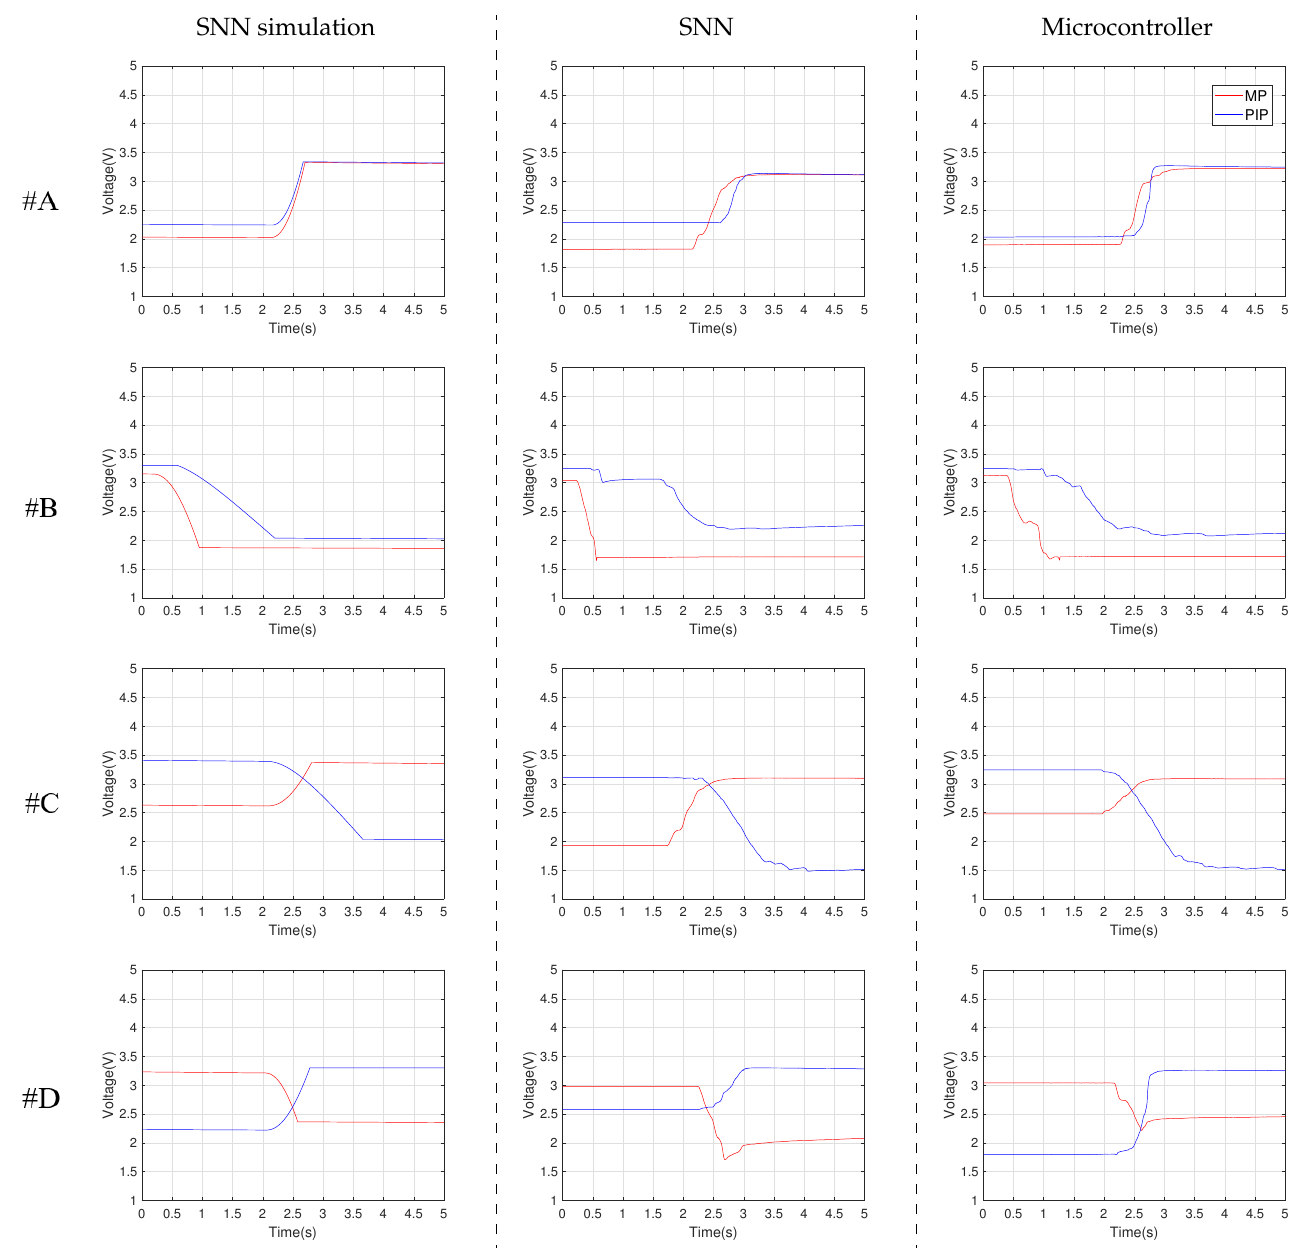
Figure 7. The output of the flex sensors for the considered motions #A–#D, according to the descrip- tion in Table 1. The columns represent the experimental method used, while each line represents a particular finger